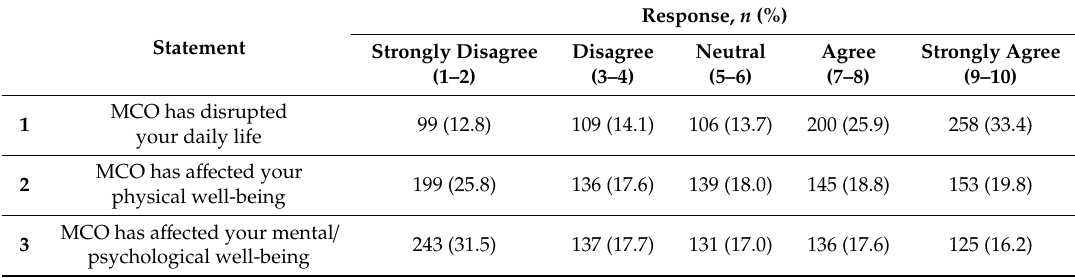
Table 4. Perception of the MCO E ff ect on